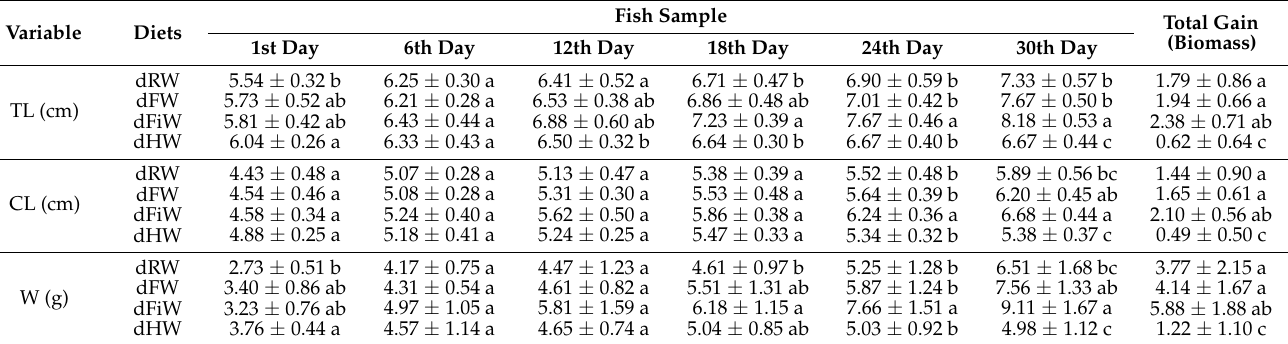
Table 5. Chronology of O. niloticus development fed on diets based on 30% of BSF meals.